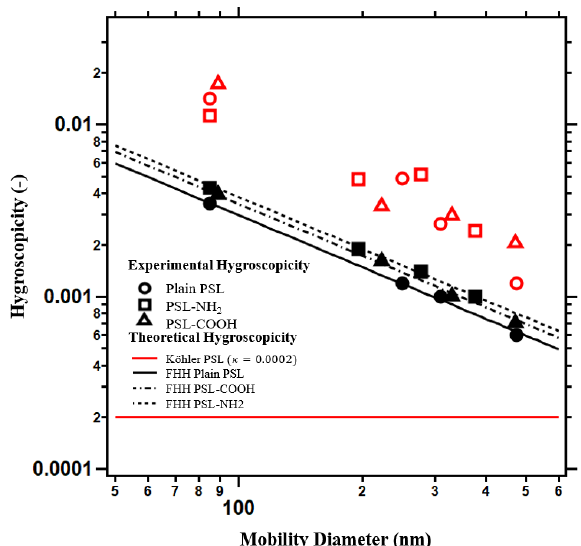
Figure 2. The single hygroscopicity parameter predicted from FHH-AT and traditional Köhler theory. Köhler theory from intrin- sic properties (solid red line) predicts a constant hygroscopicity across particle sizes and hygroscopicity derived from experimen- tal data (open symbols) shows size dependence. Hygroscopicity derived from the FHH-AT model from theory (solid black lines) and from experimental data (black symbols) are size dependent and agree well. Hygroscopicity derived from the FHH-AT model is also sensitive to functional surface